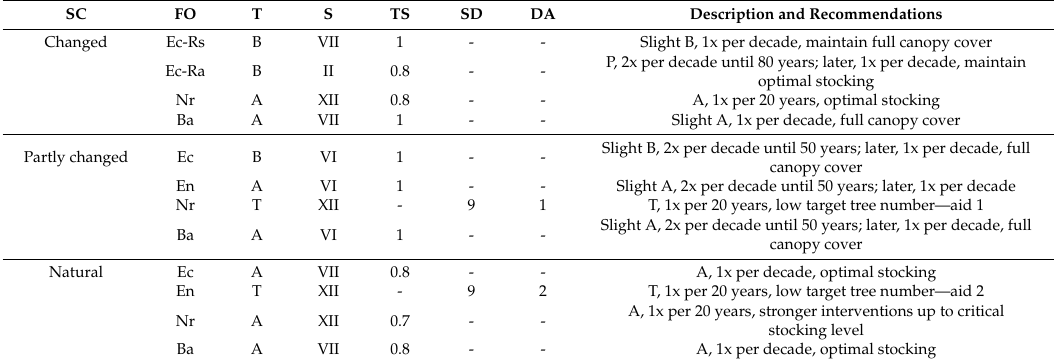
A, 1x per decade, optimal